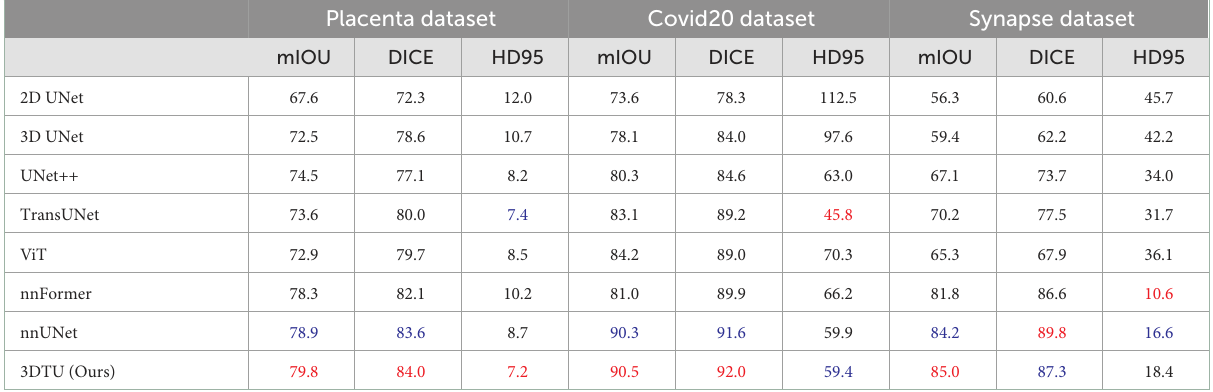
TABLE 1 Quantitative segmentation results of different methods on two datasets, where mIOU and DICE are in %. Placenta dataset Covid20 dataset Synapse